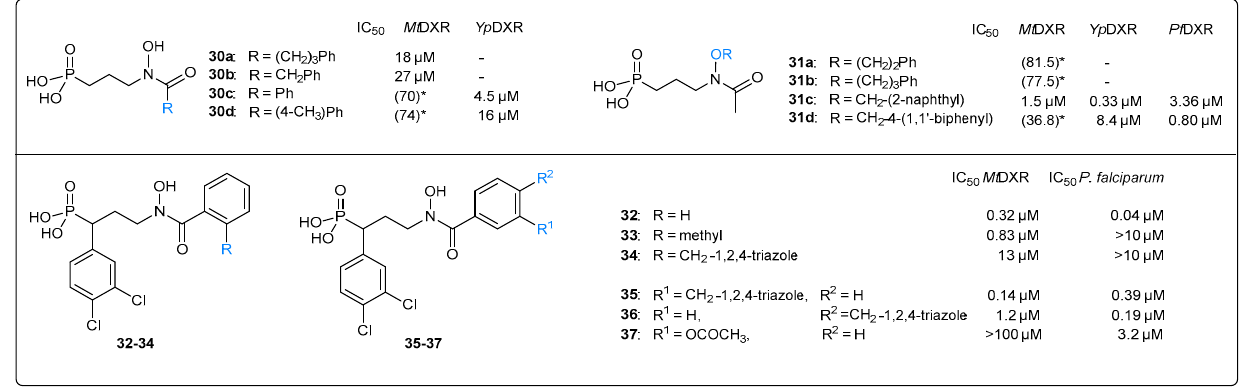
Figure 12. Biological activities of the potential bisubstrate inhibitors 30 – 37 . Values marked with * indicate the percentage of inhibition at 100 µM. * indicate the percentage of inhibition at 100 µ